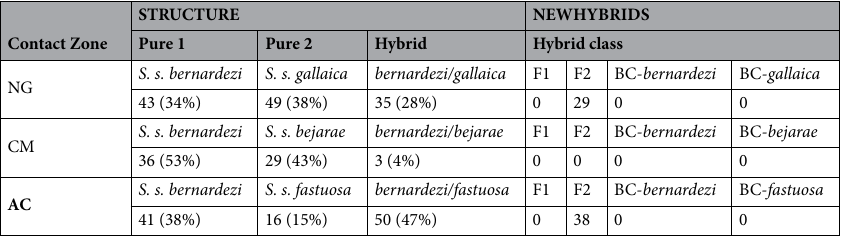
Table 1. Genetic assignments based on STRU CTU RE (Pure 1, Pure 2 and Hybrids; with both total numbers and percentages by class), and NEWHYBRIDS (F1, F2, backcrosses; total numbers by class).